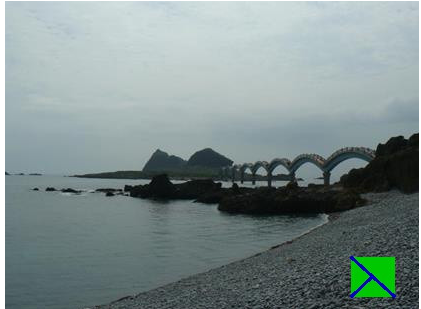
Figure 16. Shape “T cross” of thickness 2.